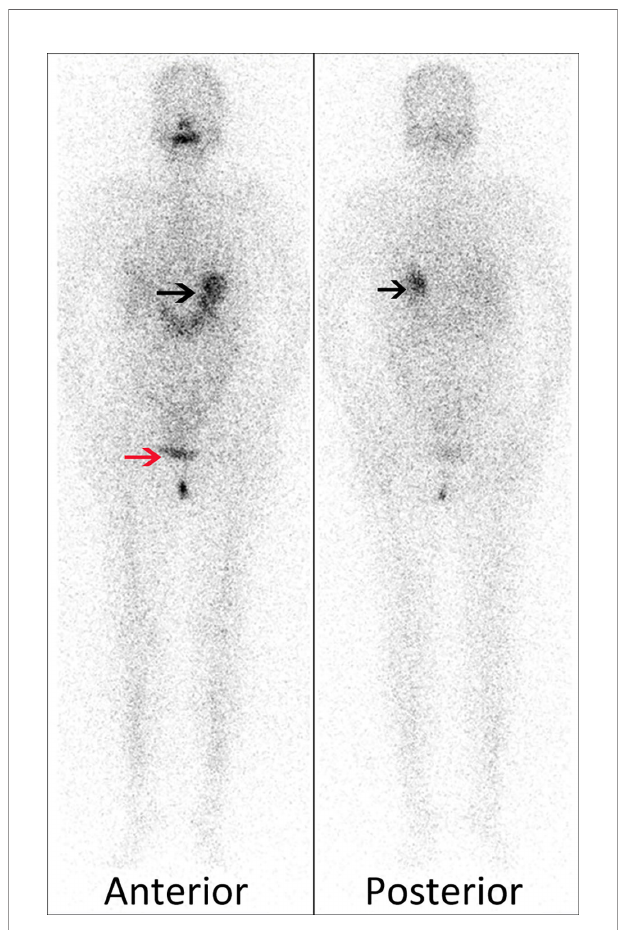
FIGURE 2 | Excepting for the physiological retention of stomach (black arrows) and bladder (red arrow), no radioactive uptake was observed in the neck and pelvic cavity on the diagnostic